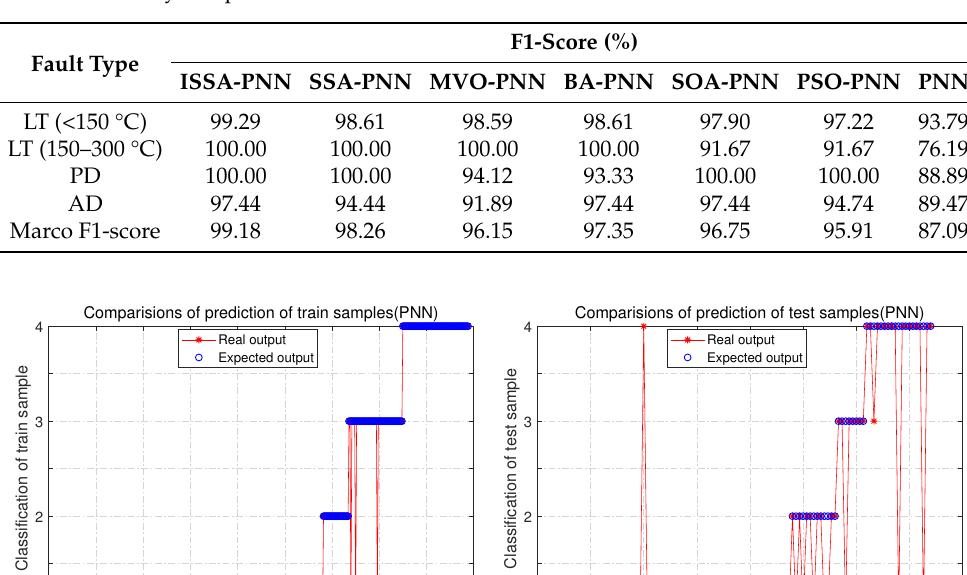
Table 8. Accuracy comparison of different methods.